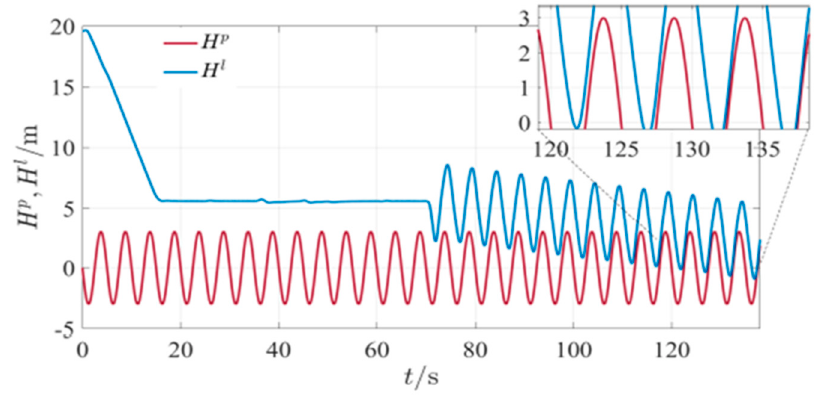
Figure 50. The evolution of H p , H l as a function of time when A w = 6 m, T w = 7.5